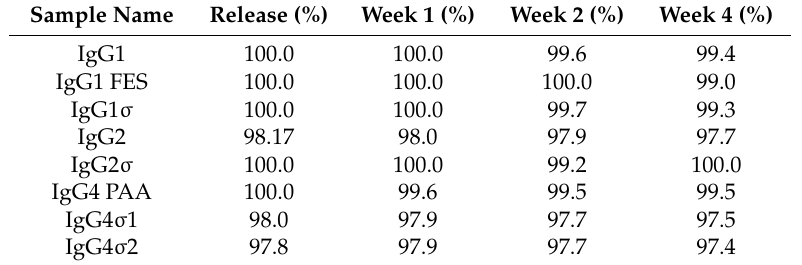
Table 4. Size exclusion chromatography (SEC) analyses with percent monomer of concentrated proteins.